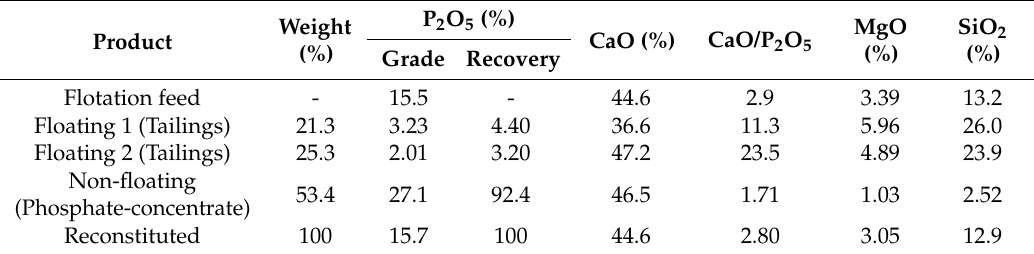
Table 10. Results of chemical analysis of the flotation feed and the flotation test